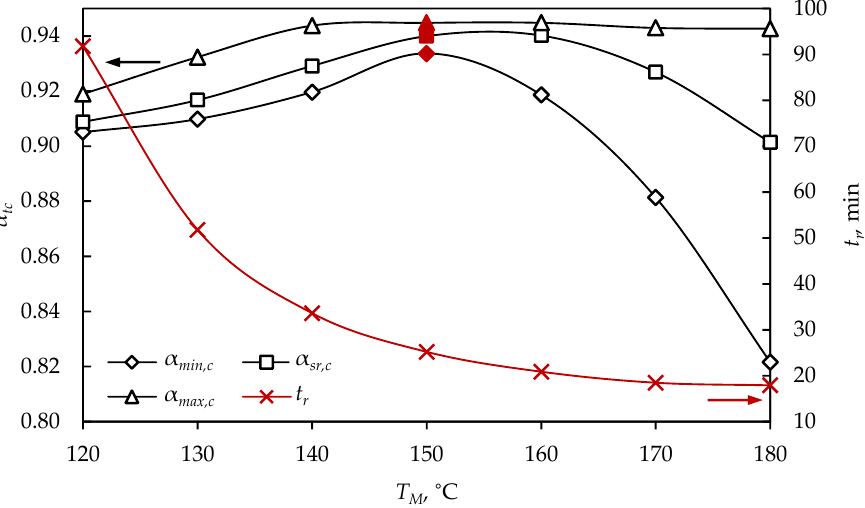
Figure 6. Vulcanization degree after cooling a sphere ( D = 5 cm), obtained at different mold temperatures. For spherical product ( D = 5 cm) vulcanized at 180 °C, it was observed that, after cooling, the minimal vulcanization degree was 0.822, which was defined as an insufficiently cured product; although the process time was the shortest (17.9 min), quality products were not obtained (Figure 6). At low mold temperatures (120 and 130 °C), vulcanization degrees higher than 0.9 were achieved, but, nevertheless, the long process time led to higher energy consumption. It can be noticed that at a temperature of 150 °C and t r = 25.2 min, the highest values of the minimal vulcanization degree (0.934) were reached after cooling, and the average and maximal vulcanization degrees were 0.94 and 0.945, respectively, indicating that the entire product volume was highly cured. In order to optimize the process, the difference between the maximal and minimal vulcanization degrees at the time of product removal from the mold ( ∆ α r ) was examined and compared with the values after cooling ( ∆ α c ), as presented in Figure